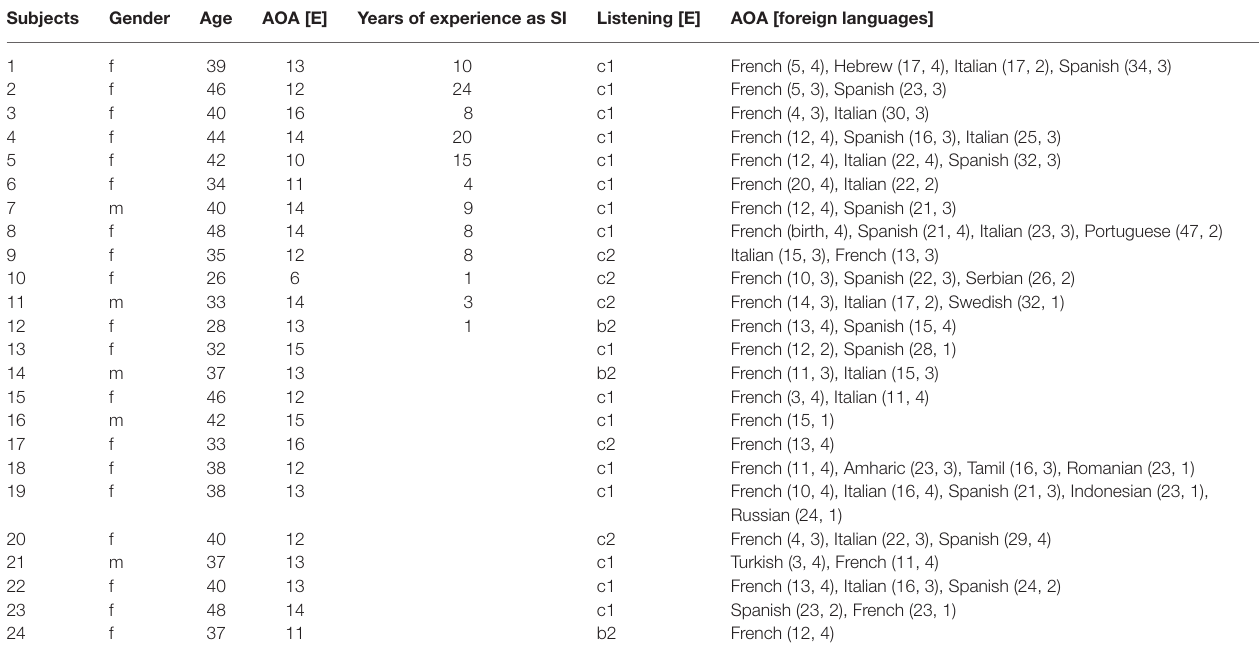
TABLE 1 | Autobiographical and behavioral data of the